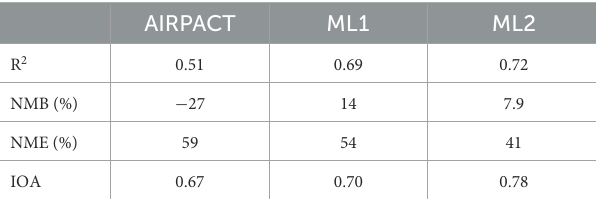
TABLE 5 Statistics of the 10-time, 10-fold cross-validations of the daily PM2.5 concentrations during wildfire season from AIRPACT and our ML models.